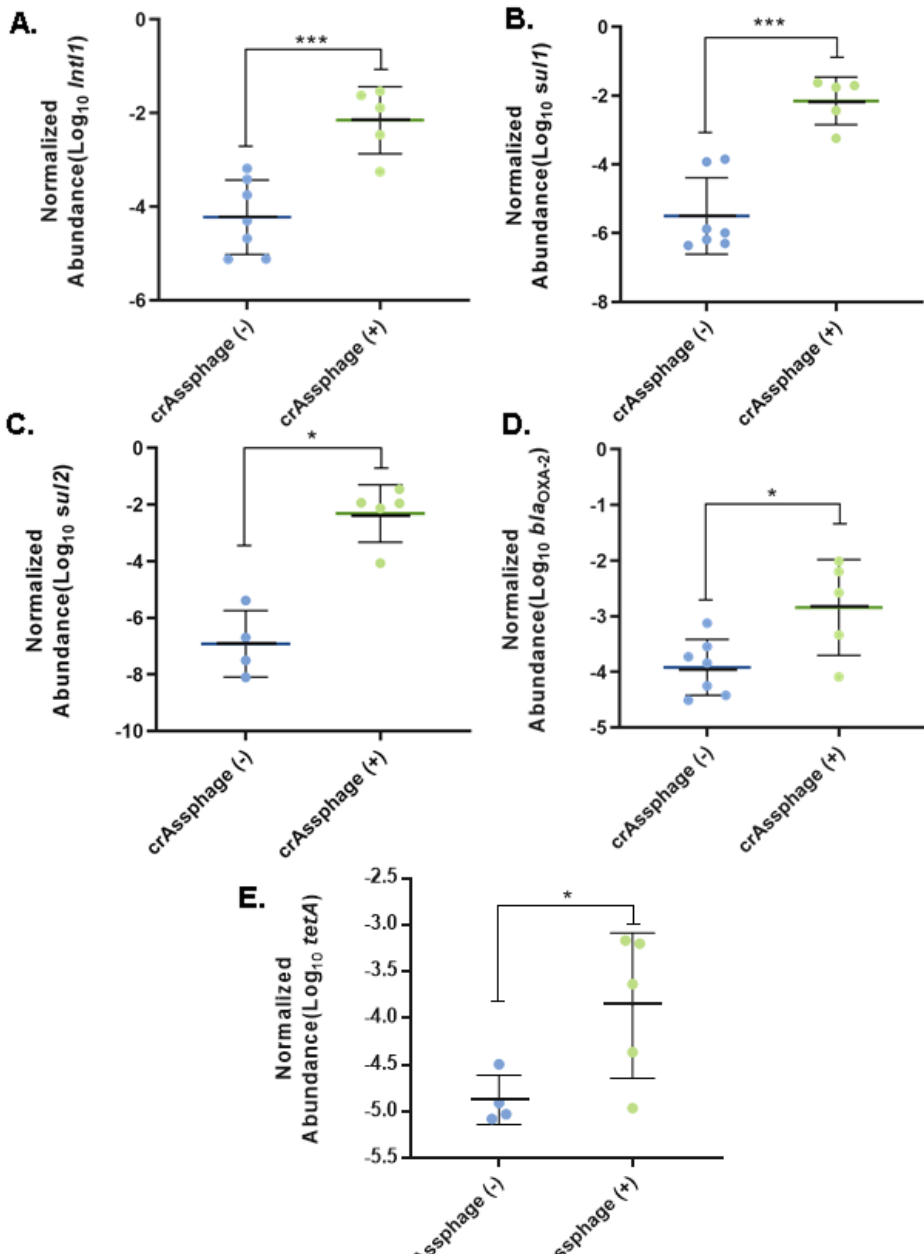
Figure 6. Abundance of ARGs and intl1 in function to the presence of crAssphage. The abundance of (A) intl1 , (B) sul1 , (C) sul2 , (D) bla OXA-2 , and (E) tetA between the samples with and without detected ( A ) intl1 , ( B ) sul1 , ( C ) sul2 , ( D ) bla OXA-2 , and ( E ) tetA between the samples with and without detected crAssphage were compared using ANOVA. * p < 0.05, ** p < 0.01, *** p < 0.001. crAssphage were compared using ANOVA. * p < 0.05, ** p < 0.01, *** p <